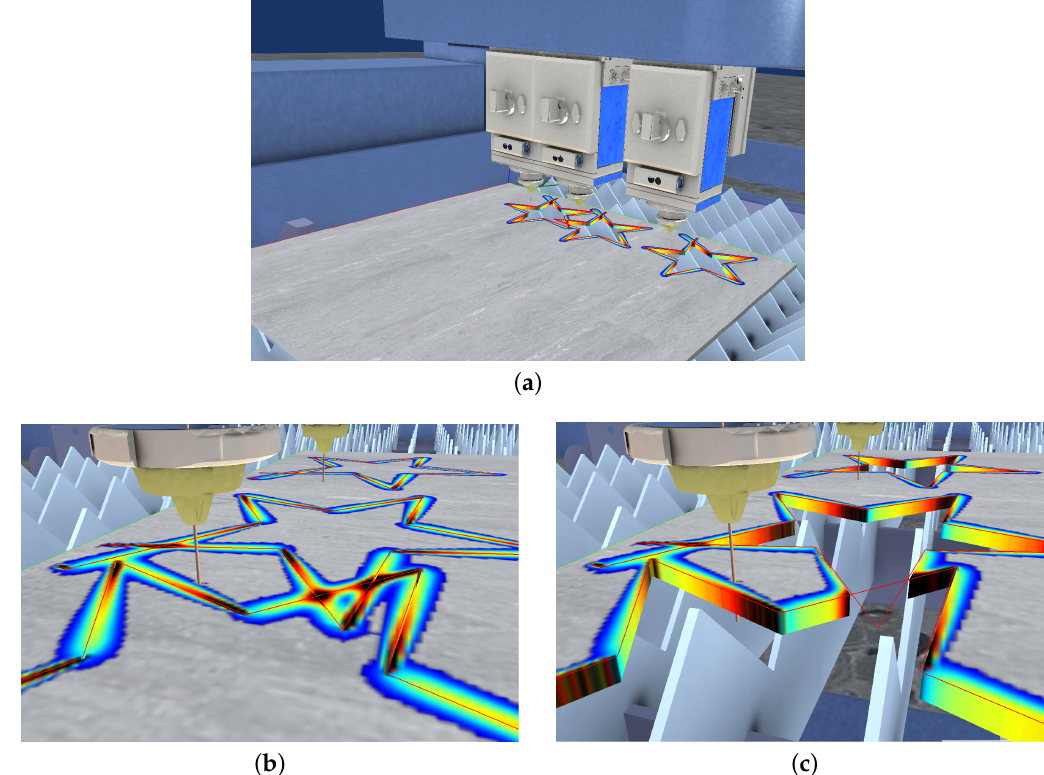
Figure 11. Multi-laser machining in the interactive simulator. A star shape is machined by the three laser heads. ( a ) virtual multi-laser machine; ( b ) temperature shown on the sheet surface; ( c ) geometric cut of the